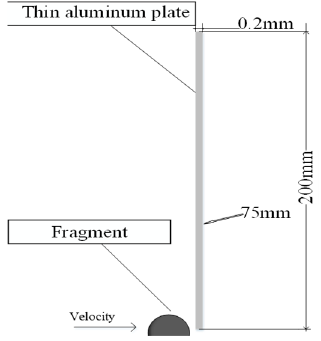
Figure 2. Numerical simulation model of broken film impact